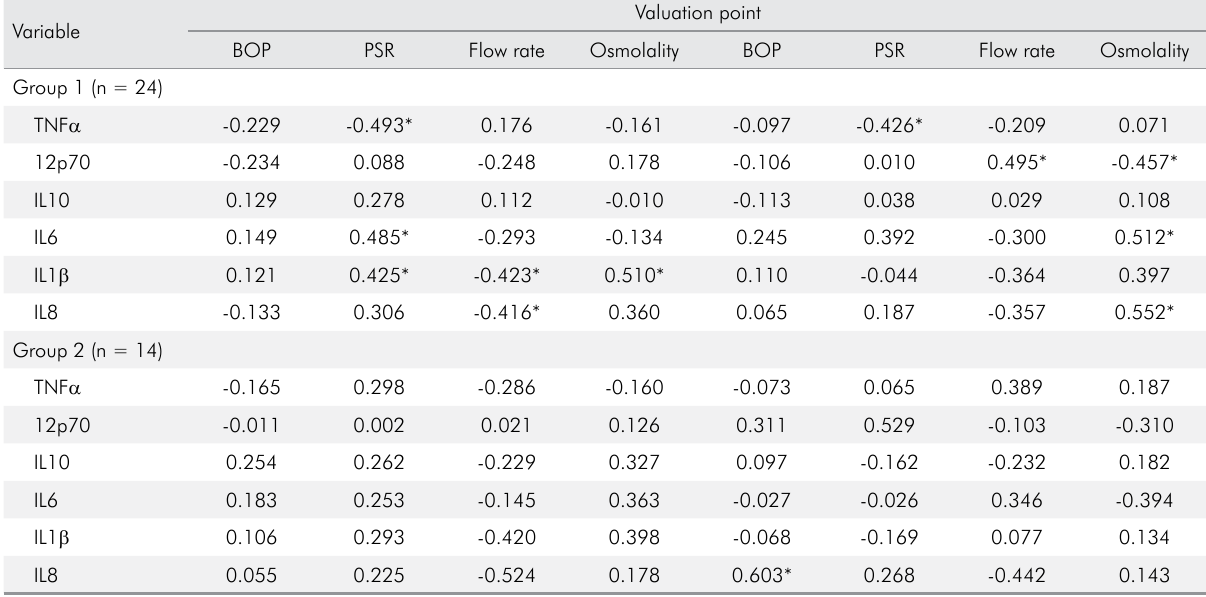
Table 3. Spearman correlation coefficients among variables of BOP, PSR, salivary flow, salivary osmolality and salivary concentrations of markers TNF α , IL-1 β , IL-6, IL-8, IL-10 and IL-12p70.